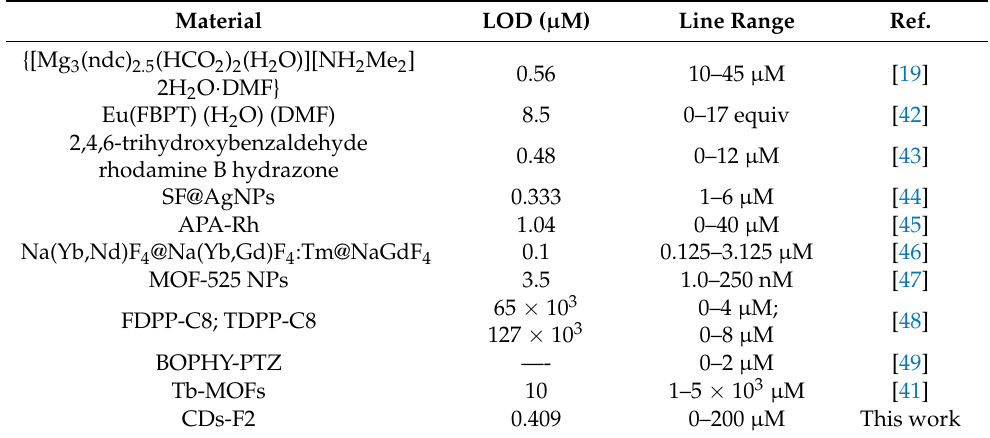
Table 1. Comparison of LOD and line range of CDs-F2 with other probes for Cu 2+ detection. Material LOD ( µ M) Line Range